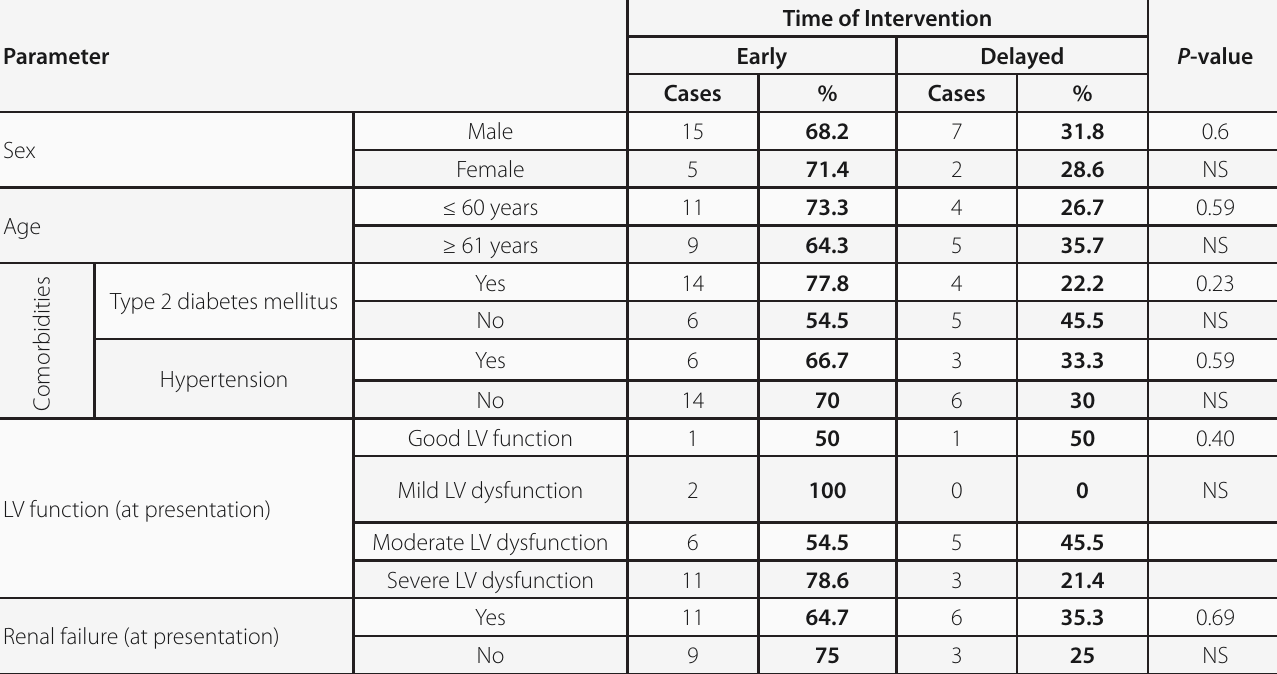
Table 1. Two cohorts matched for age, sex, comorbidities, left ventricular function, and renal failure.